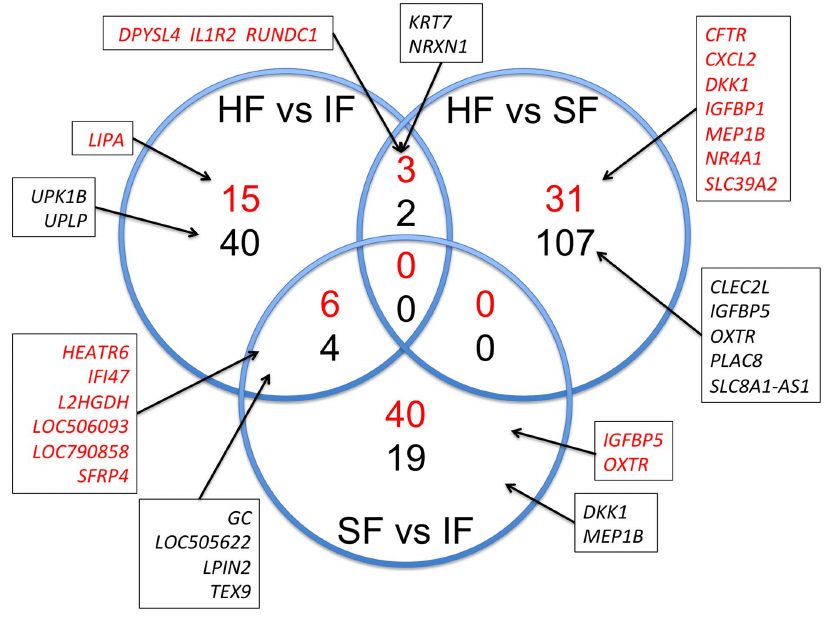
Figure 4. Venn diagram showing the number of unique or common transcripts between the endometrium of fertility-classified heifers (HF, high fertile; SF, subfertile; IF, infertile). Up-regulated (red) and down-regulated (black) genes are presented (P , 0.01 and no false discovery rate with greater than 1.5-fold change). A few up- and down-regulated genes are highlighted in the boxes.